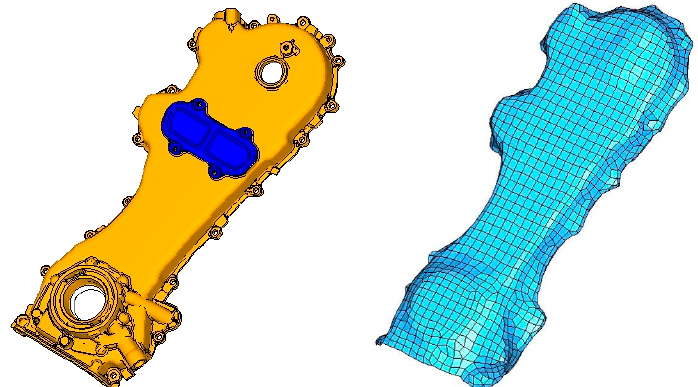
Figure 2. Boundary element method (BEM) model of the chain cover.